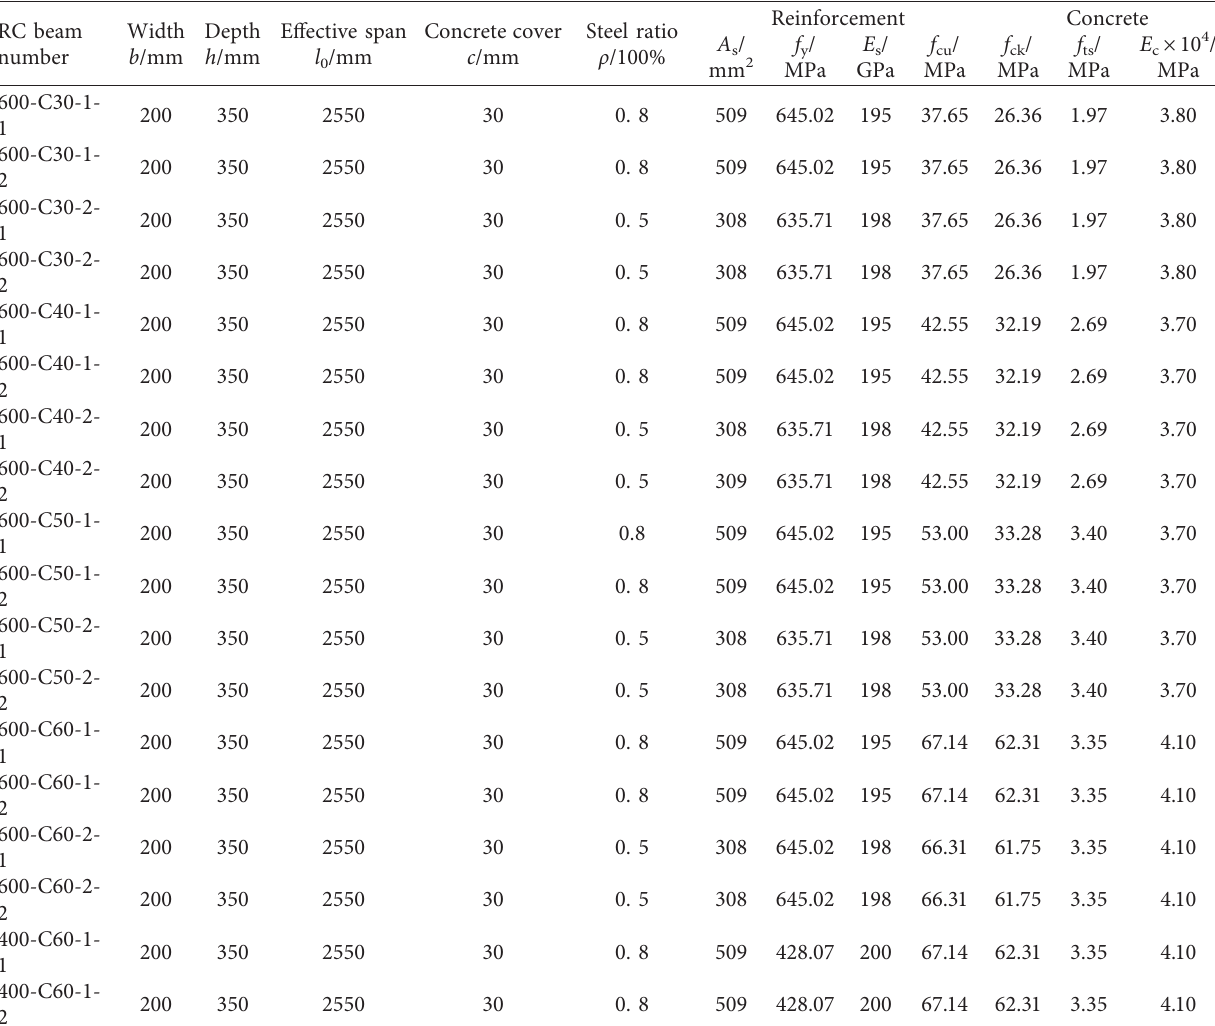
Table 5: Size and reinforcement and material properties of tested